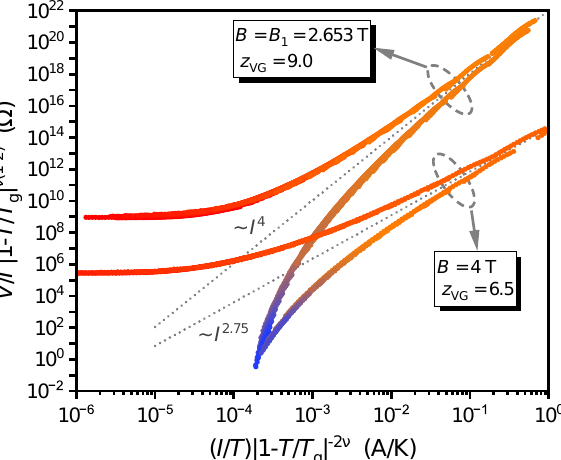
Figure 4. Comparison of the collapsed V / I vs. I curves at the first matching field B 1 = 2.653T and at an off-matching field B = 4T. The dotted lines indicate the bifurcation and have different exponents. Color coding is the same as in Figure